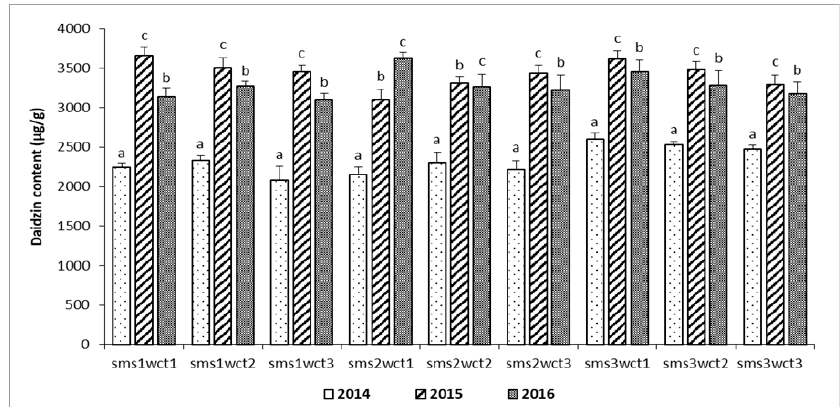
Figure A2. Daidzin concentration in soybeans influenced by field year. Sms: soil tillage system and wct: weed control treatment. The values shown are means ± S.E. Different lowercase letters above the bars indicate significant differences in daidzin concentration between the years undergoing the same treatment, according to Tukey’s HSD test ( P ≤ 0.05).